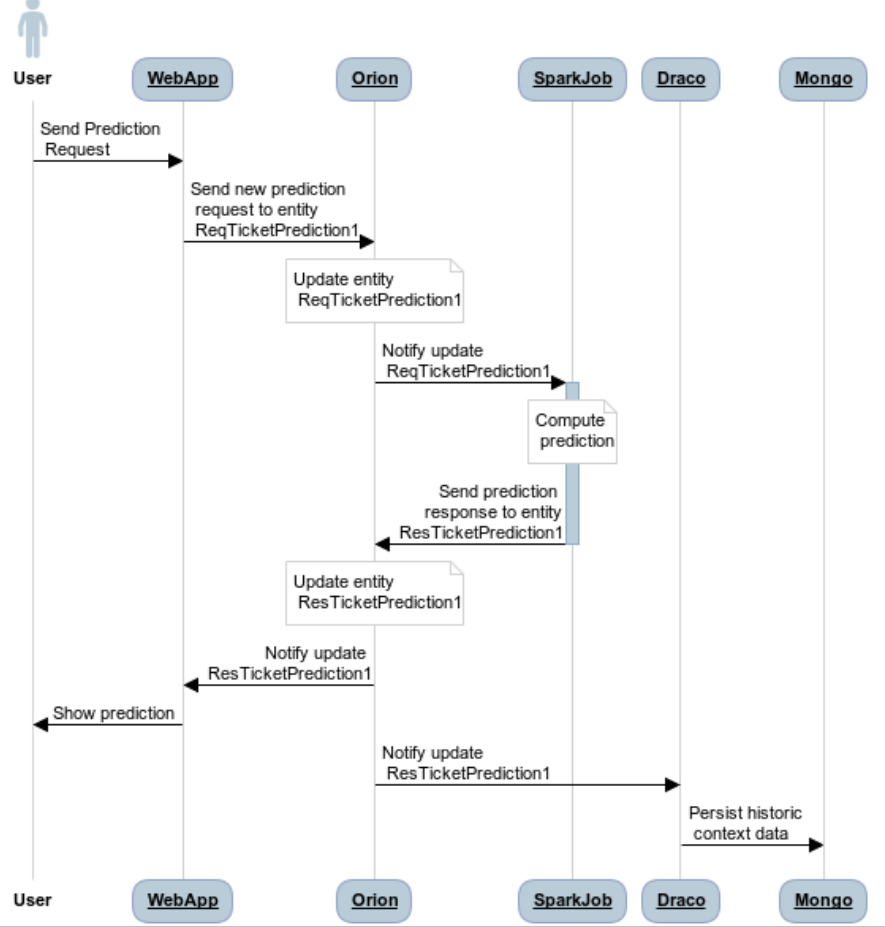
Figure 12. Purchase prediction systems